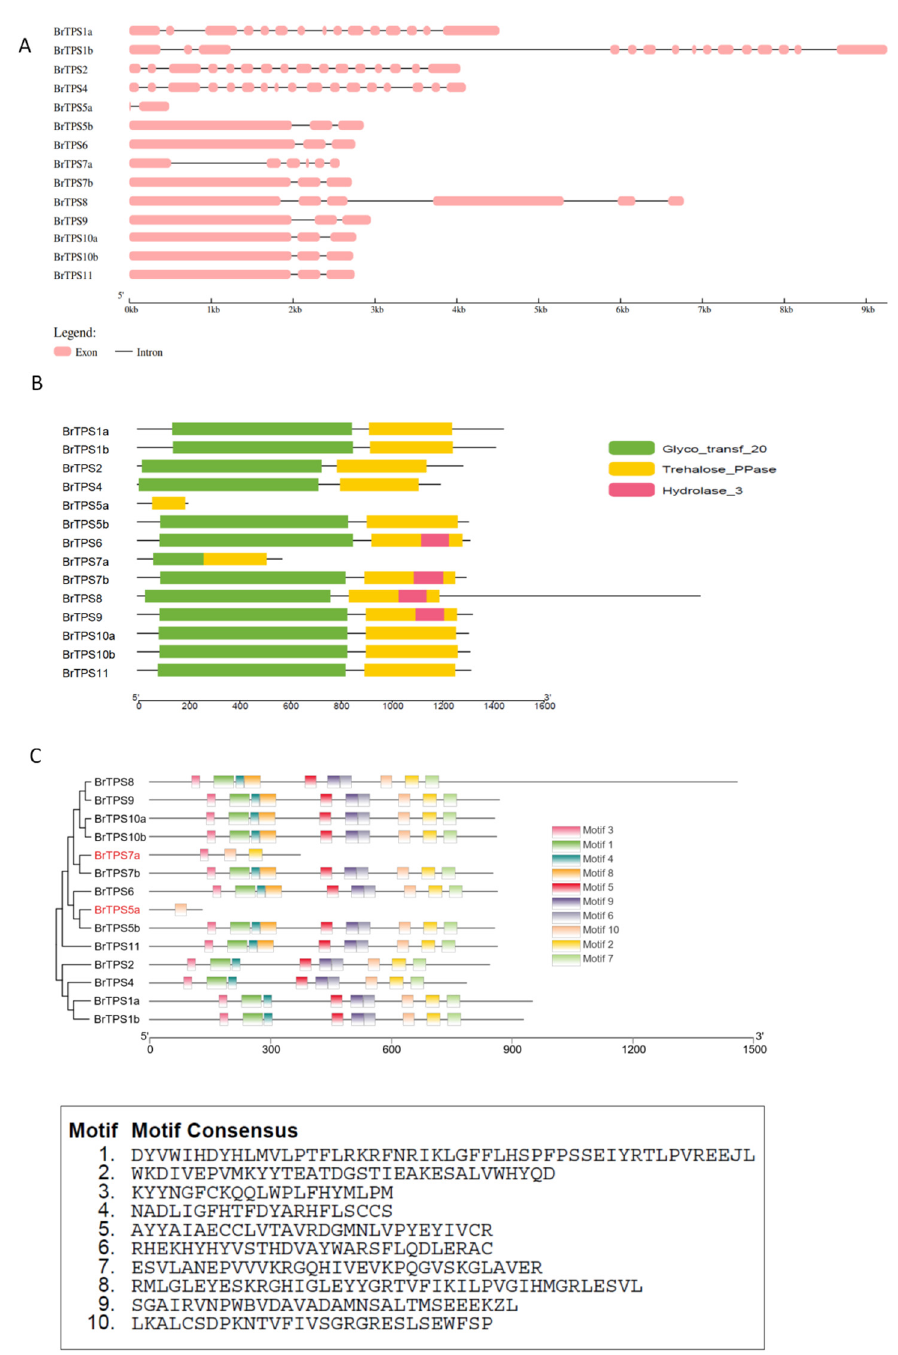
Figure 3. Gene structures, domains, and motifs of the BrTPS family. ( A ) Exon/intron organization of BrTPS genes. Pink boxes represent exons and black lines of same length represent introns. The length of exons can be inferred by the scale at the bottom. ( B ) The conserved domain analysis of BrTPS protein. Trehalose-6-phosphate synthase (TPS) domain (Glyco_transf_20), trehalose-6-phosphate phosphatase (TPP) domain (Trehalose_PPase), and haloacid dehalogenase-like hydrolase domain-containing 3 (Hydrolase 3) are shown by green, yellow, and red, respectively. ( C ) Conserved motifs of BrTPS proteins. Ten putative motifs are indicated in different colored boxes. The details of the motifs are listed at the bottom.